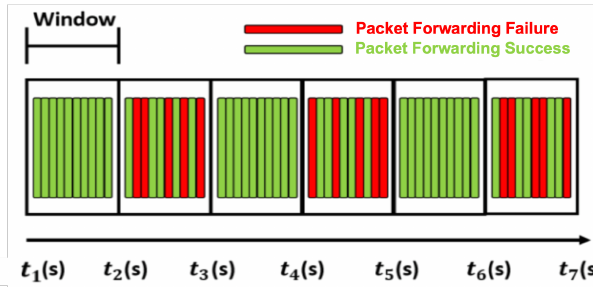
Figure 7. Packet forwarding according to the time window.